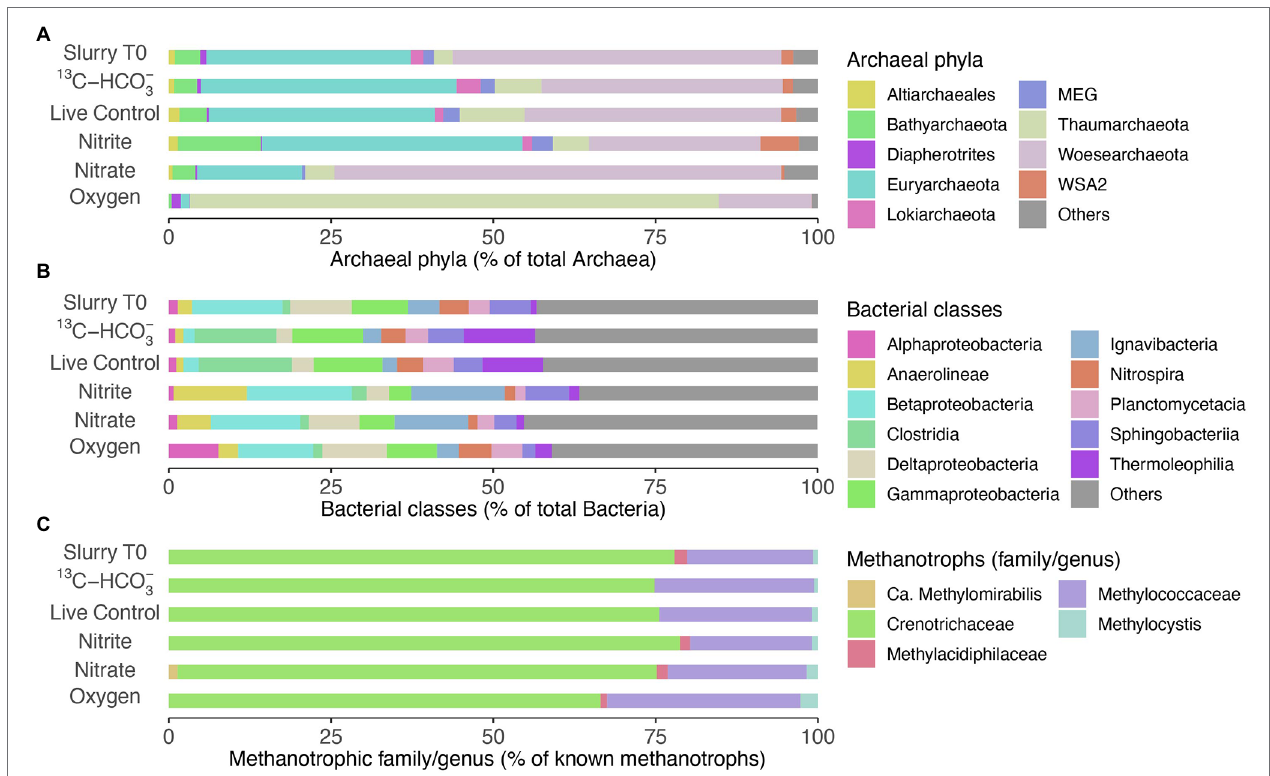
FIGURE 5 | Microbial communities in slurry samples before (Slurry T0) and after incubation (160 days) with different treatments. (A) Relative abundances of the most abundant phyla within the Archaea (>90% of total archaeal sequences). (B) Relative abundances of top bacterial classes (>50% of total bacterial sequences). (C) Fractional abundances of known methanotrophic families/genera, Methylocystis was dominant within the family Methylocystaceae . Data are based on read abundances of 16S rRNA gene